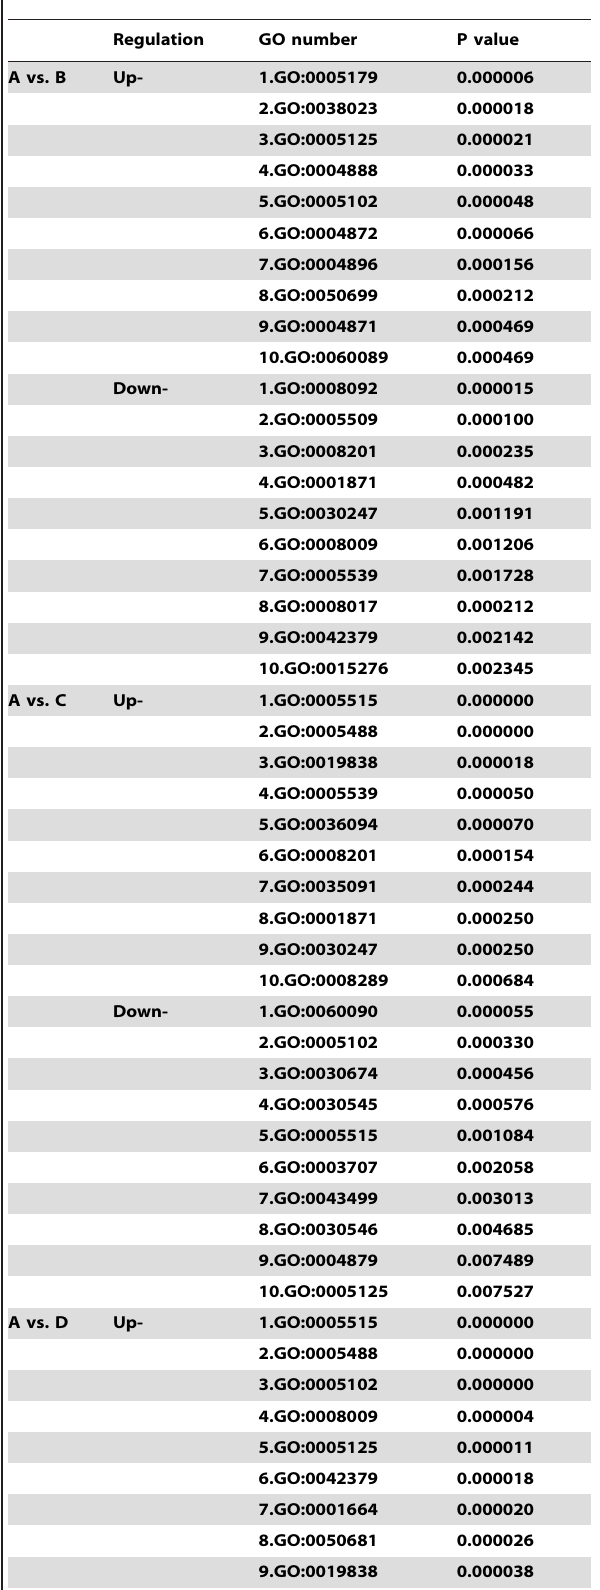
Table 4. GO molecular function annotations in